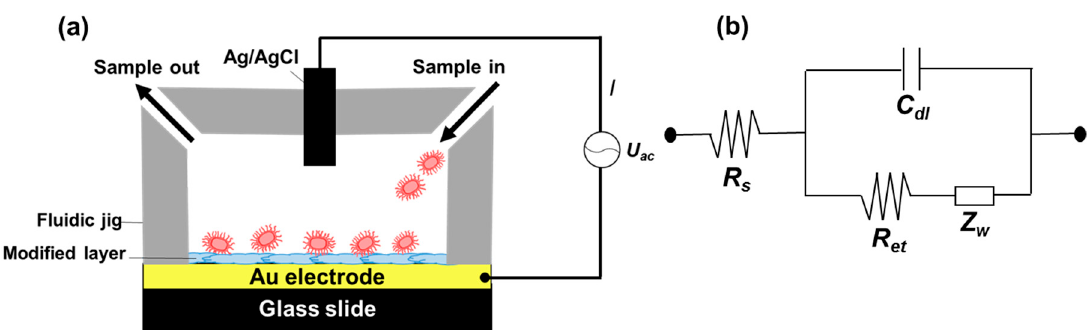
Figure 2. Experiment setup showing the sensing chamber composed of a surface functionalized gold electrode and a Teflon jig ( a ). AC power was connected to a potentiostat that supplied the required current between the functionalized electrode and Ag/AgCl electrode located on top of the fluidic chamber; ( b ) shows a circuit diagram of the set up used for electrochemical impedance spectroscopy measurements in the presence of a redox probe ( b ). The circuit elements shown are; solution resistance ( R s ), interfacial electron transfer resistance ( R et ), Warbug’s impedance ( Z w ), and double layer capacitance ( C dl ).